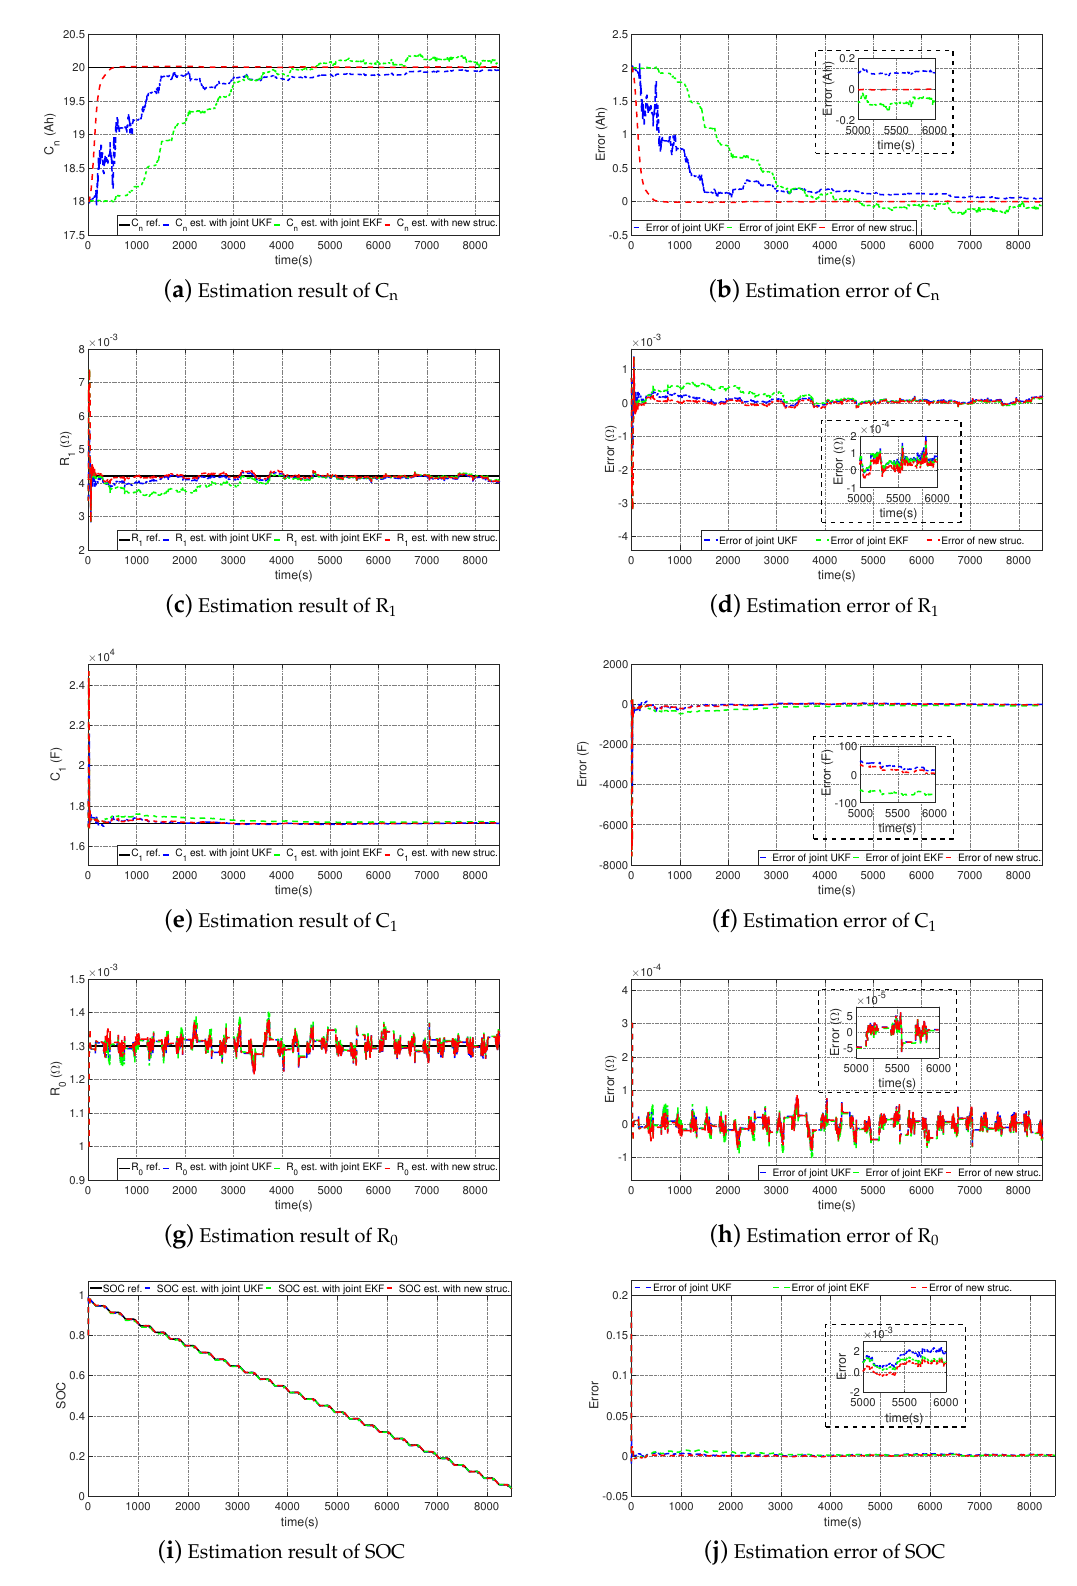
Figure 14. Comparison of the estimation results with joint EKF, joint UKF, and the new